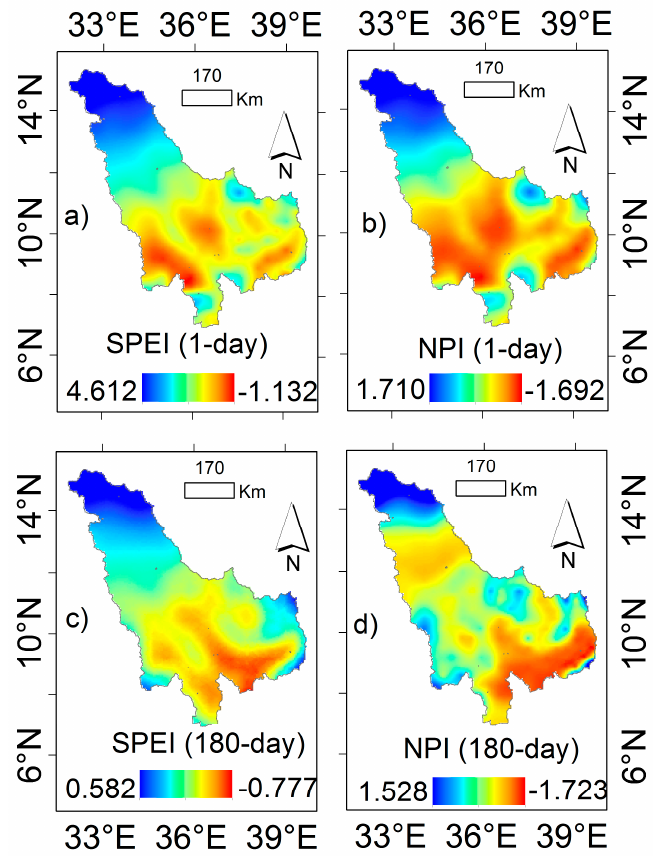
Figure 10. Meteorological dry and wet conditions in terms of: ( a , c ) SPEI; and ( b , d ) NPI applied to catchment-wide daily precipitation insufficiency. The label text in “( )” of the legend shows the aggregation level.